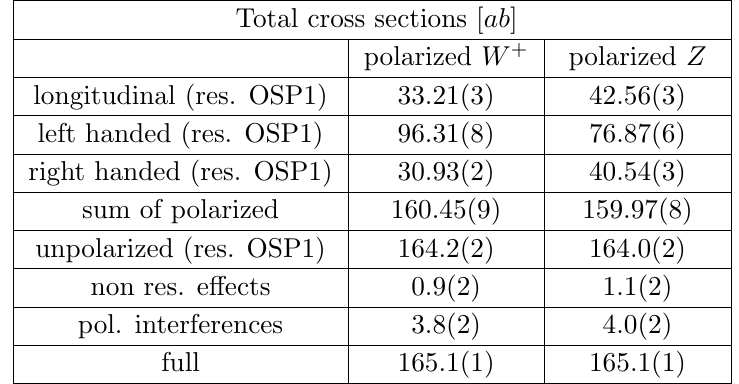
Table 13 . Polarized and unpolarized total cross sections ( ab ) for W + Z scattering in the (cid:12)ducial region (see section